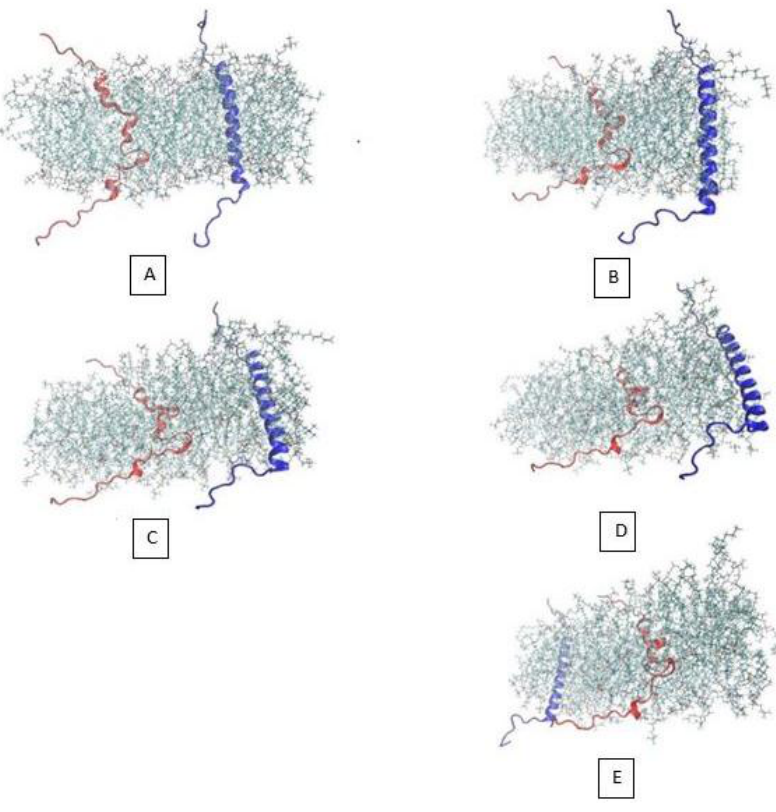
Figure 2. Different simulation stages of all-atom α-subunit SMD method.